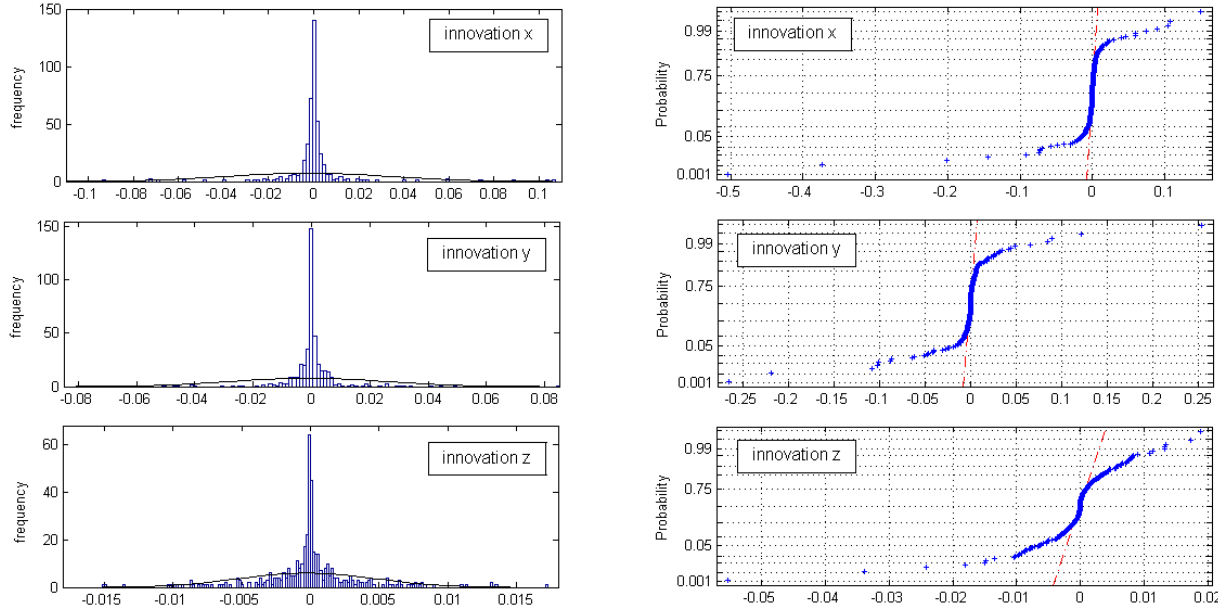
Figure 7. Probability distributions for innovations x , y , z : Histograms with a normal density function ( Left ) and normal probability plots ( Right ).